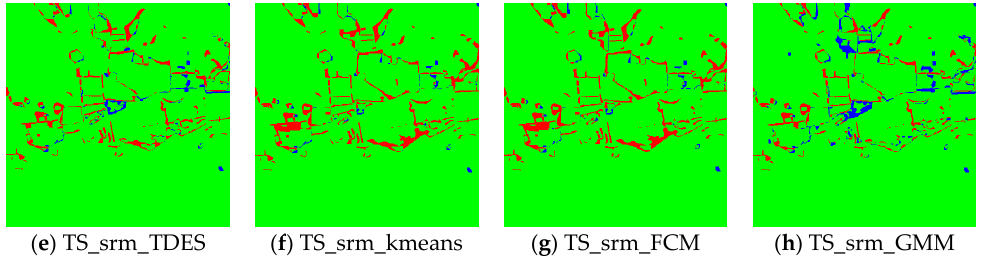
Figure 11. The qualitative comparisons change detection results of the different algorithms over YanDong Lake.